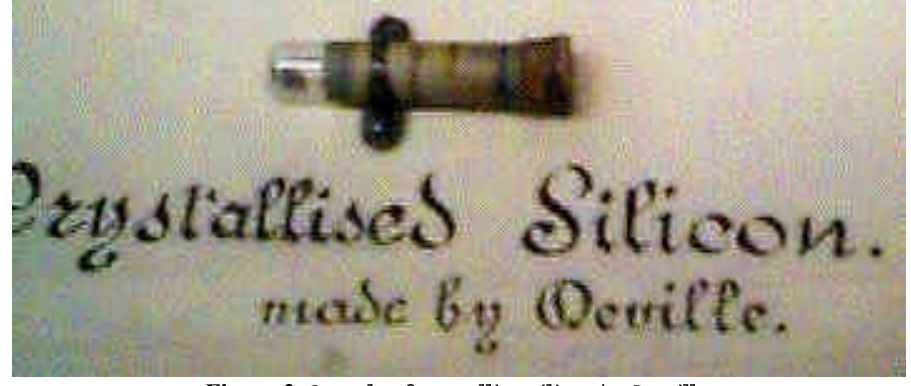
Figure 3. Sample of crystalline silicon by